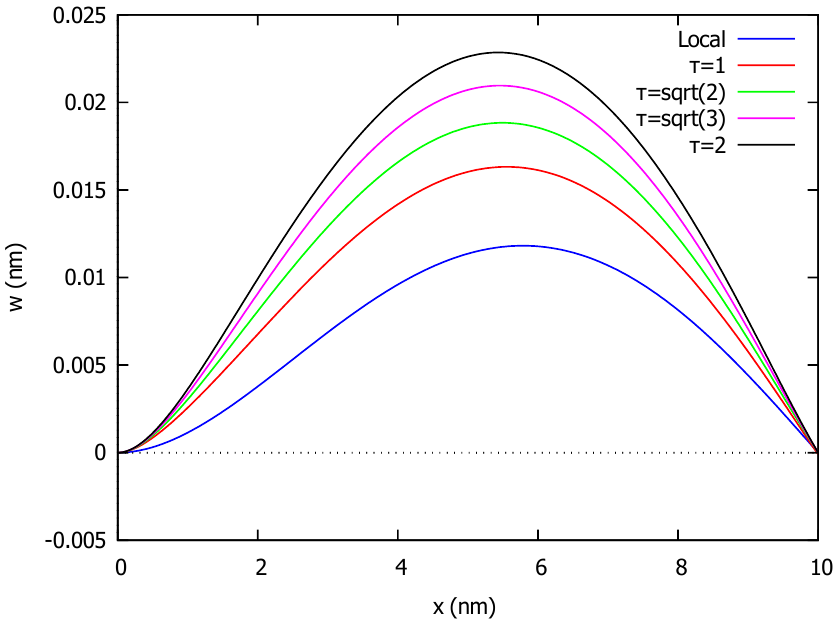
Figure 4. Deflection of clamped pinned beam (CP) under uniform load and several values of τ .